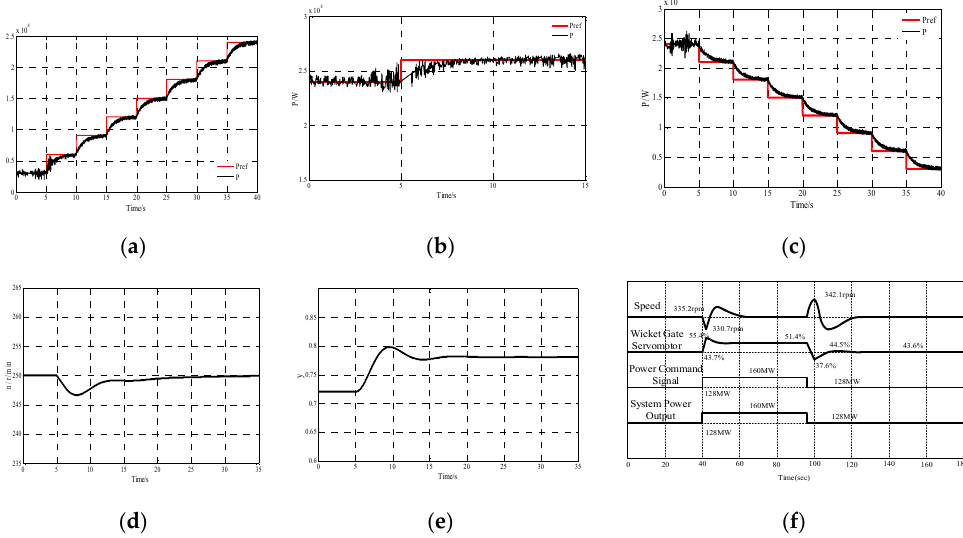
Figure 11. Simulation waveforms of unit in generating mode: ( a ) active power in load ramping stage; ( b ) active power in stable operation stage; ( c ) active power in load rejection stage; ( d ) speed in stable operation stage; ( e ) guide vane opening in stable operation stage; ( f ) actual dynamic responses for a DFVSPS unit in stable operation.